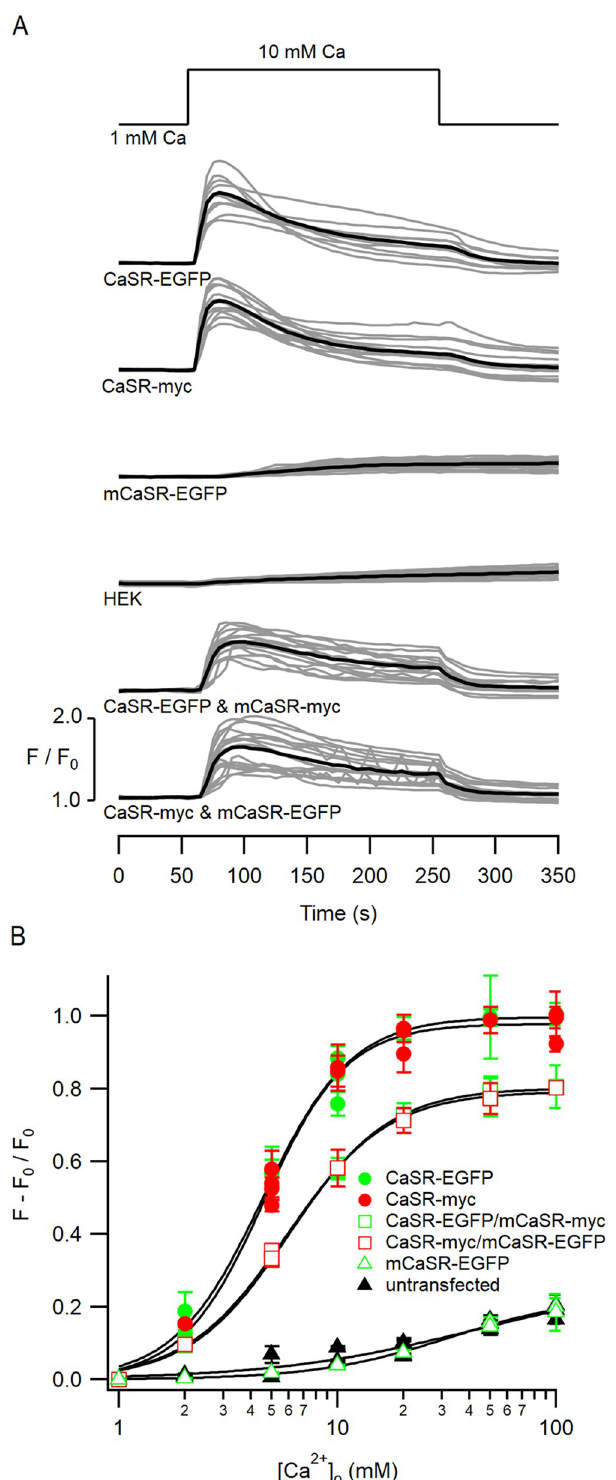
Fig 4. [Ca 2+ ] o -effect relationship for wild-type and mutant CaSR expressed alone or together. A, the time courses of increases in [Ca 2+ ] i , following the increase of [Ca 2+ ] o from 1 to 10 mM, in HEK cells transfected with pEGFP/CaSR, pcDNA-myc/CaSR, pEGFP/mCaSR, pEGFP/CaSR and pcDNA-myc/mCaSR, or pEGFP/mCaSR and pcDNA-myc/ CaSR or untransfected controls. [Ca 2+ ] i changes, shown as F/F 0 , was measured in cells grown on glass coverslips and